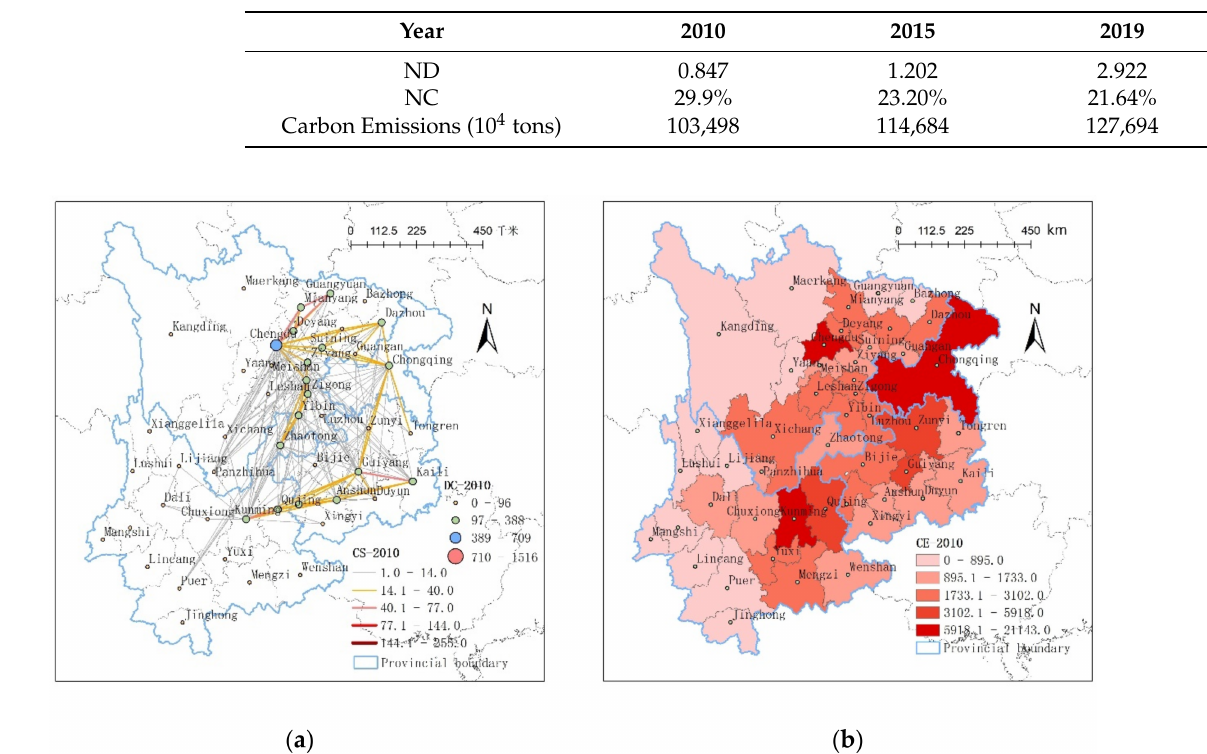
Figure 2. ( a ) Urban networks in southwest China in 2010. ( b ) Carbon emissions in southwest China in